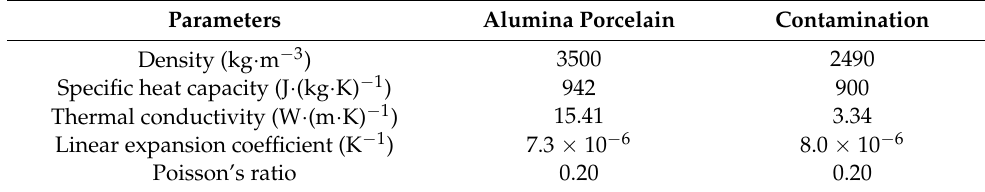
Table 1. Material